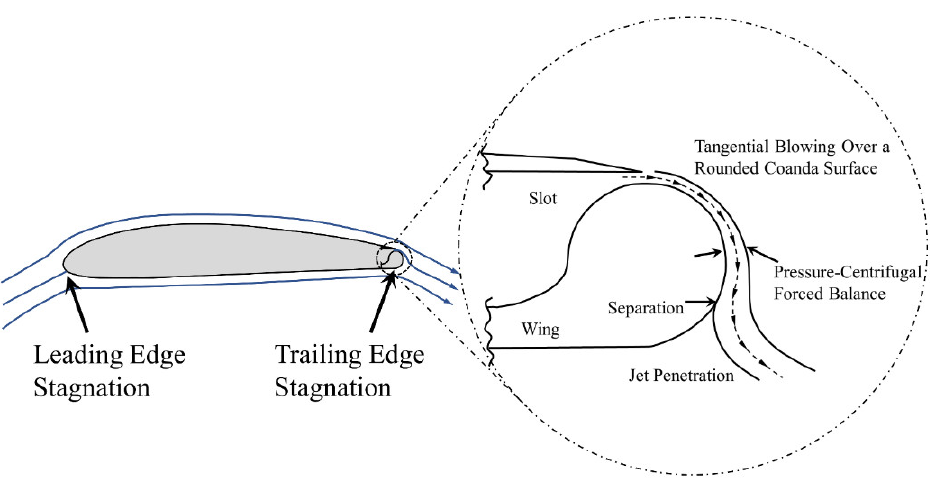
Figure 1. The influence of Coanda effect on streamlines and the concept of circulation control.